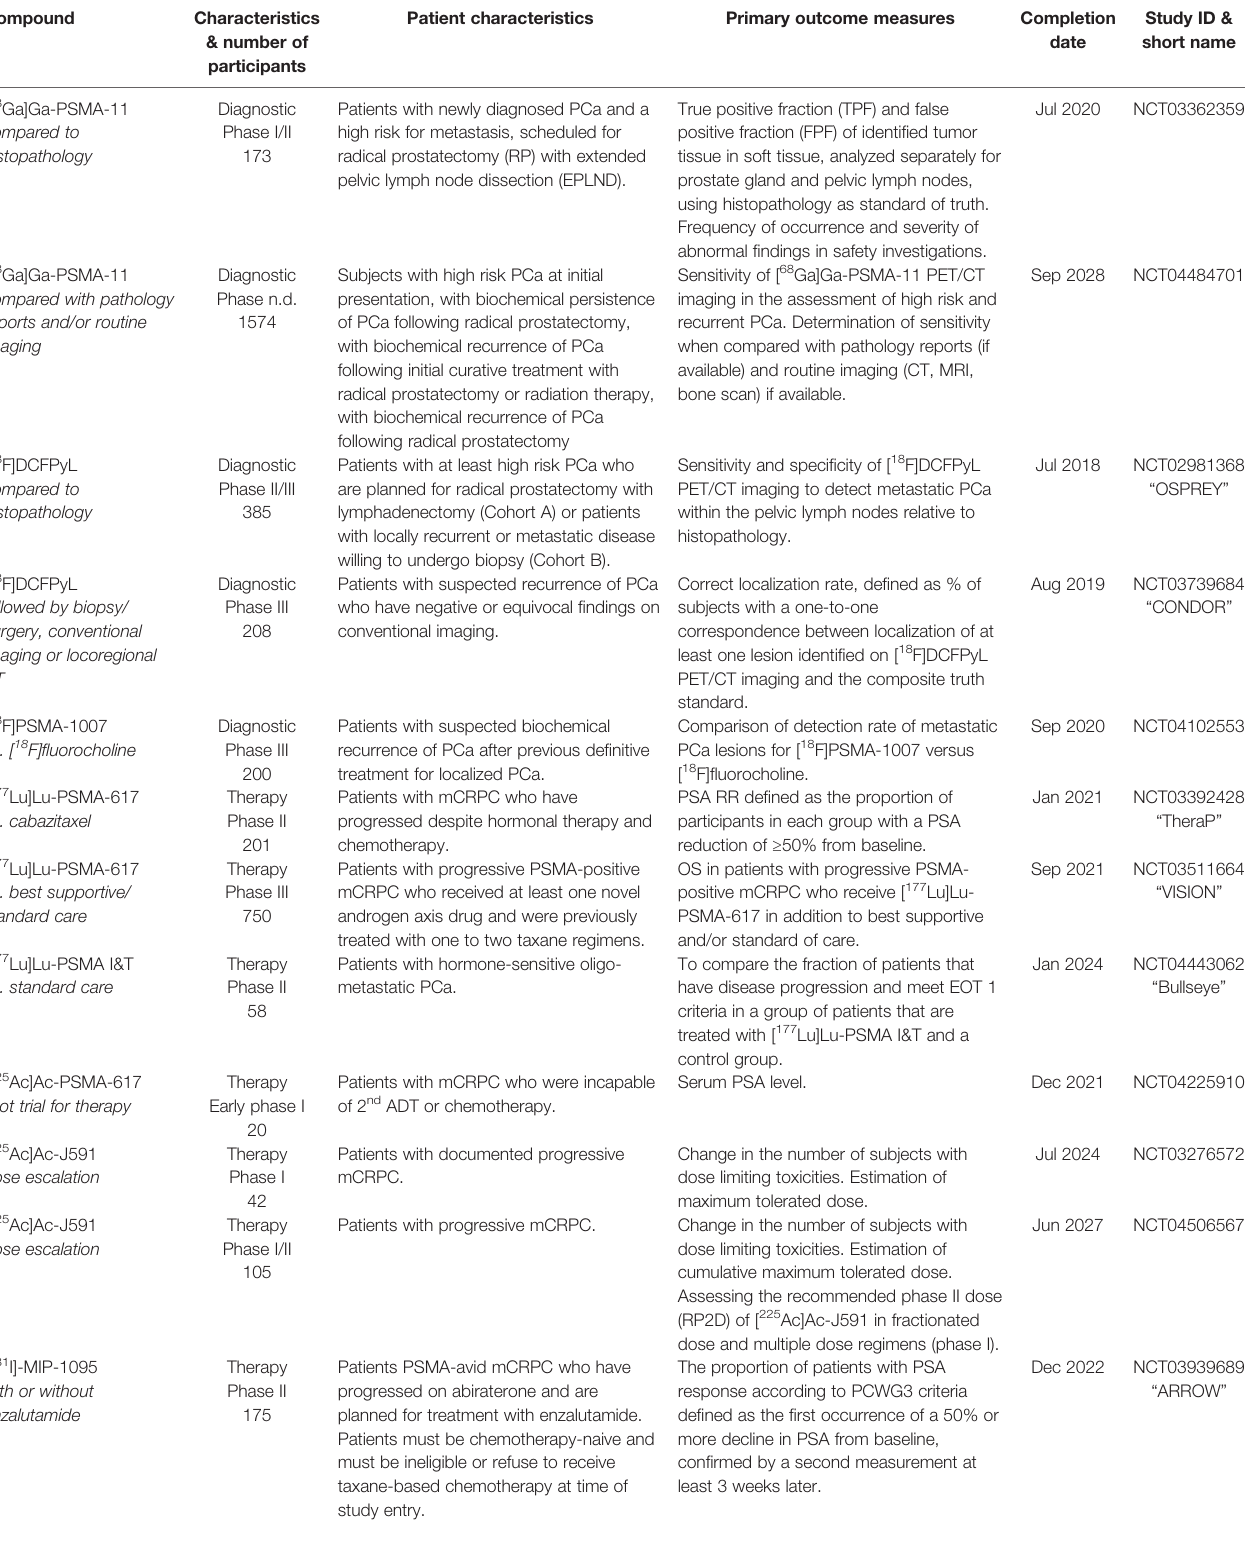
TABLE 1 | Clinical trials applying radiopharmaceutical in PCa patients, including patient characteristics, therapeutics, outcome, study